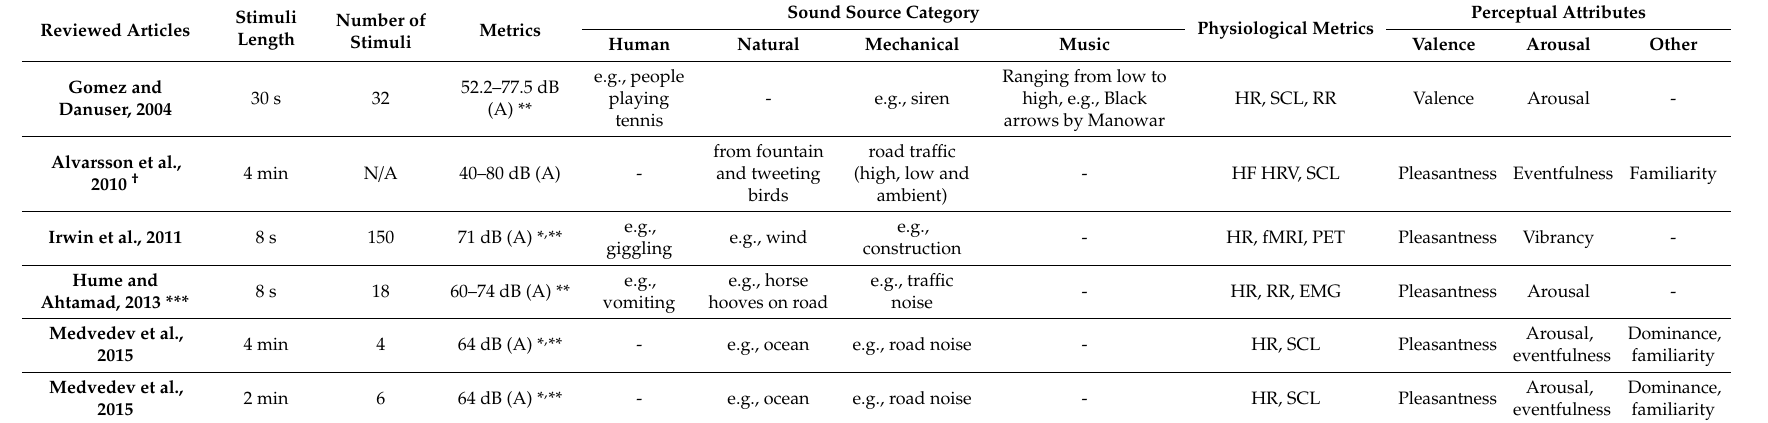
Table 1. Summary of the review studies ( n =